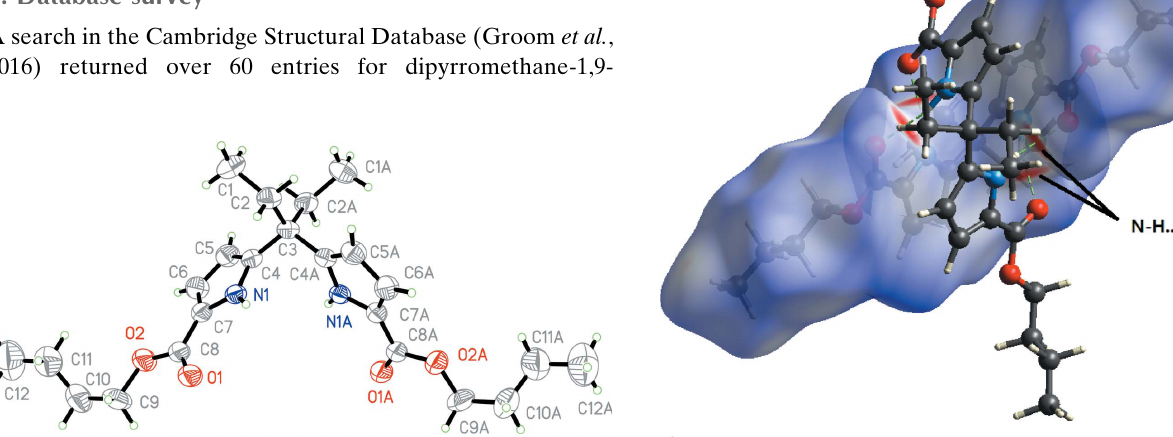
Figure 3 The Hirshfeld surface of the title compound mapped over d norm in the range (cid:3) 0.486 to 1.895 a.u. The intermolecular contacts can be seen in the (cid:3) y , 1 (cid:3) z red regions. 4 4